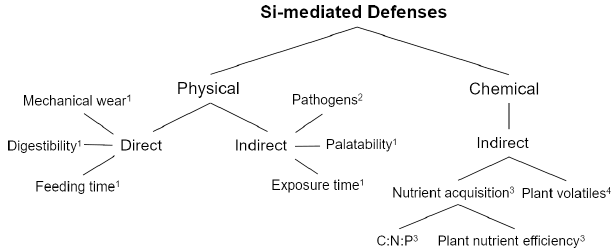
Figure 2. Direct and indirect physical and chemical plant Si- mediated defenses to herbivory. 1 Massey and Hartley (2009) and references therein. 2 Lev-Yadun and Halpern (2019). 3 Neu et al. (2017). 4 Liu et al.